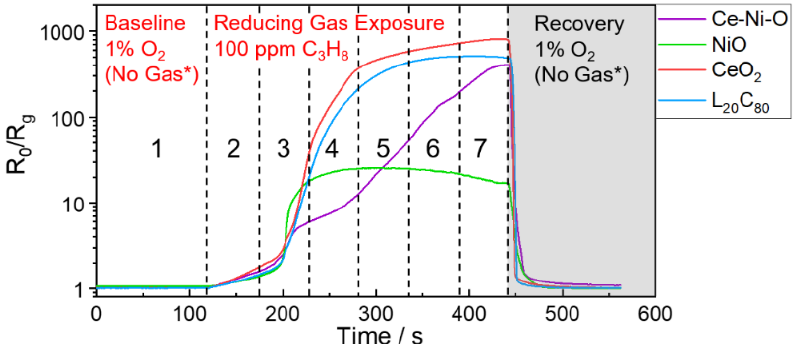
Figure 5. Illustration of time-series data of the sensor array responses to 100 ppm propane as an example, indicating the effective area (grayed-out recovery region is not considered) and the region segmentation (#1–7) for early-stage classification analysis. No Gas* means no reducing gas in the gas flow.